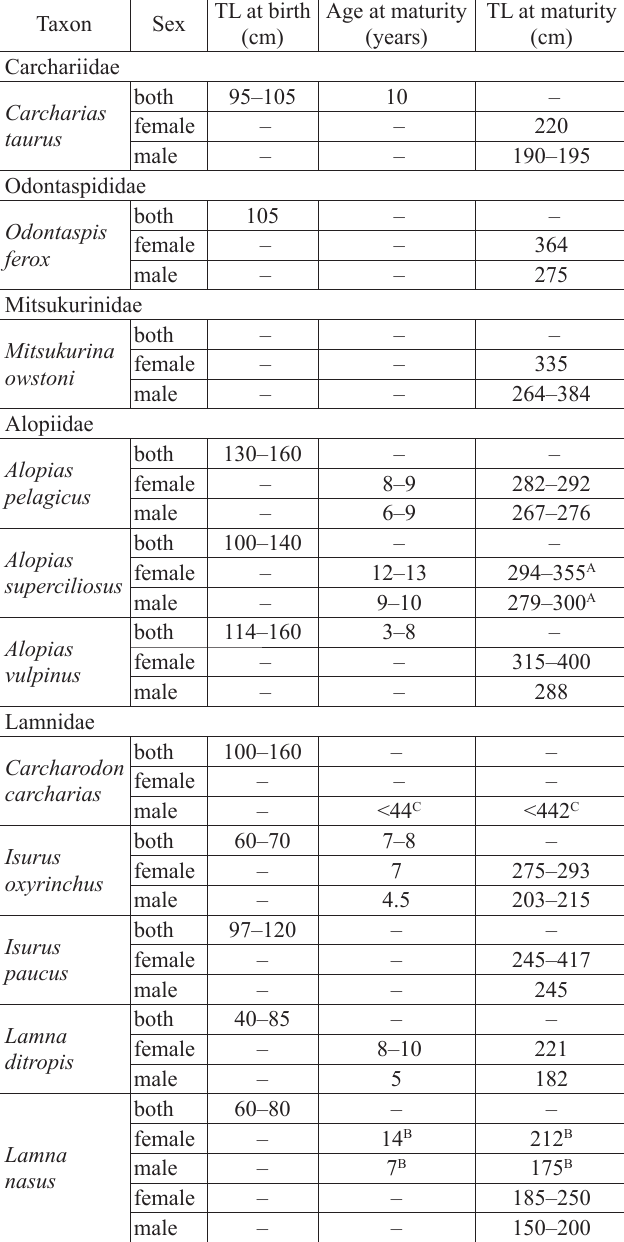
Table 1. Total length (TL) at birth, age at maturity, and TL at maturity for five families of lamniforms. Unless otherwise noted information is from Compagno (2001), A Liu et al. (1998), B Campana et al. (2002), C Hamady et al.